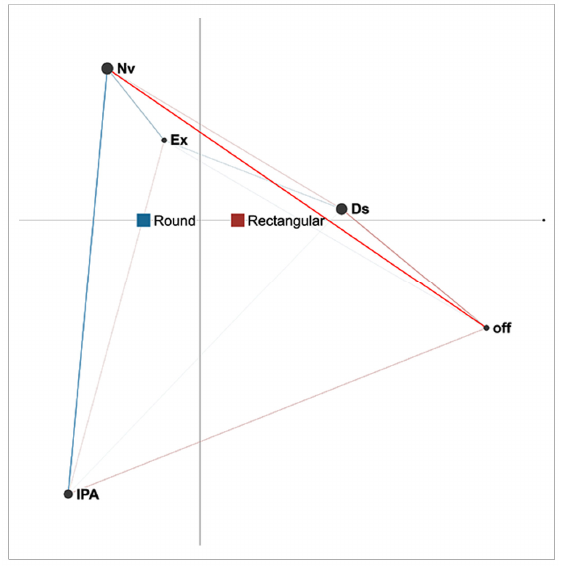
Figure 5. Difference network for female students under two conditions (round and rectangular tables).